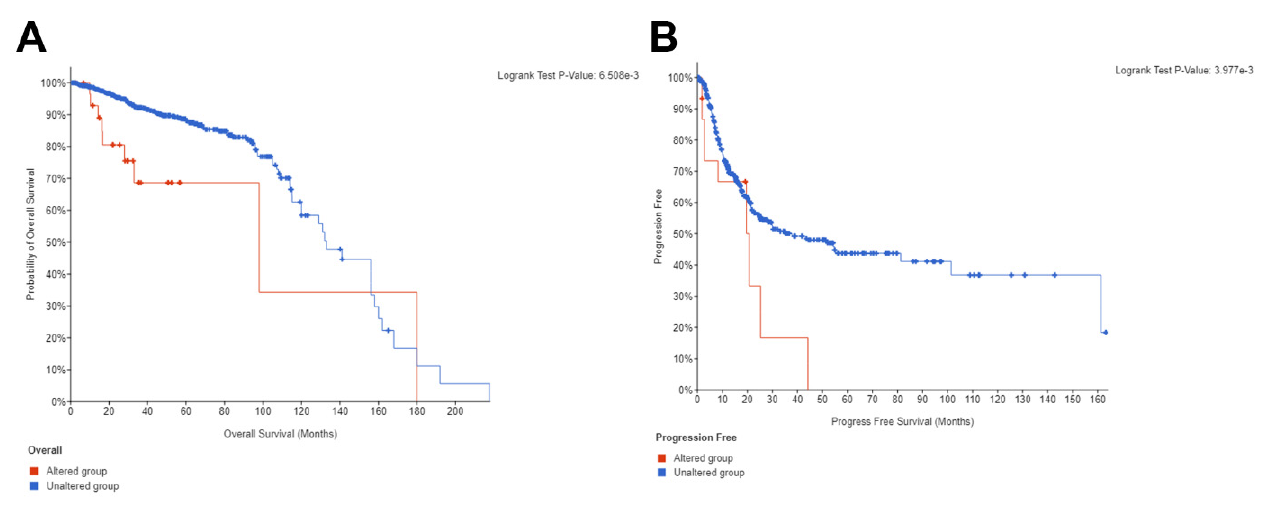
Figure 3. ARPC1B genomic alteration KM for ( A ) PCa overall survival and ( B ) Bladder cancer progression free survival. Data obtained from cBioPortal (contains all TCGA datasets, ~12.5 K samples combined for the bladder and prostate cancer together.